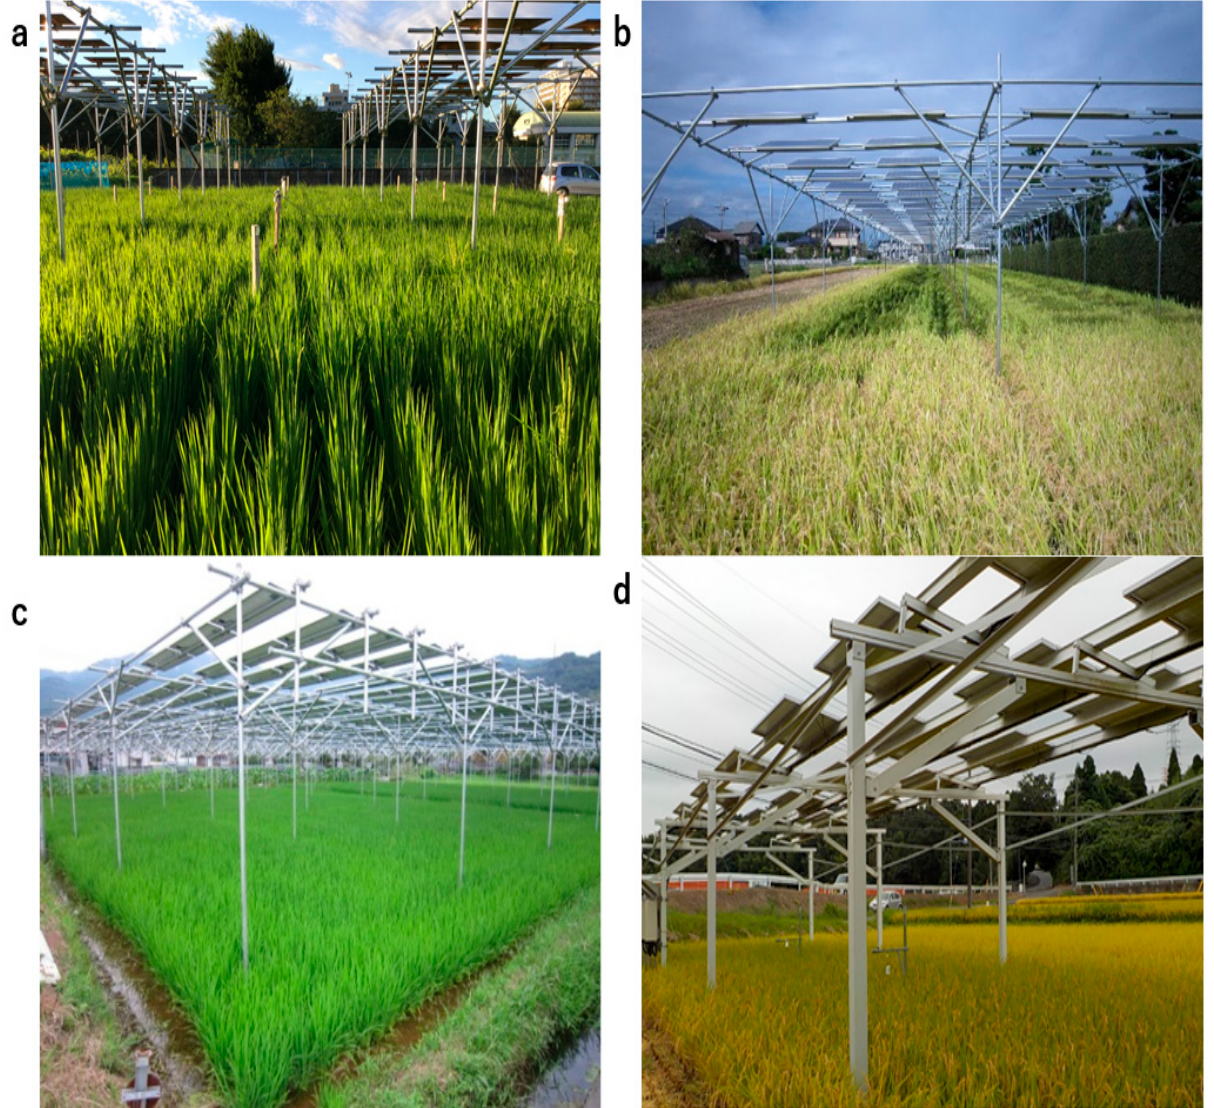
Figure 1. Case study sites of agrivoltaic systems at experimental Farm A and private Farms B, C, and D. ( a ) Experimental Farm A, located in Tokyo, with wooden boards replicating solar panels. Large and small boards are visible on the right and the left sides of the picture, respectively. ( b – d ) Private farms: Farms B and C are in the Shizuoka Prefecture, while Farm D is located in the Chiba Prefecture.